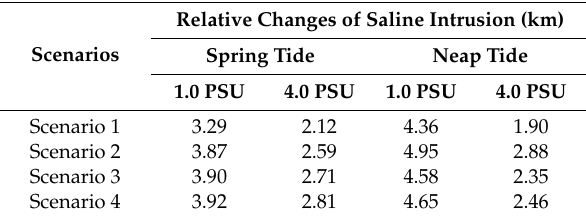
Table 8. The relative change of salinity intrusion length for four scenarios compared to baseline.